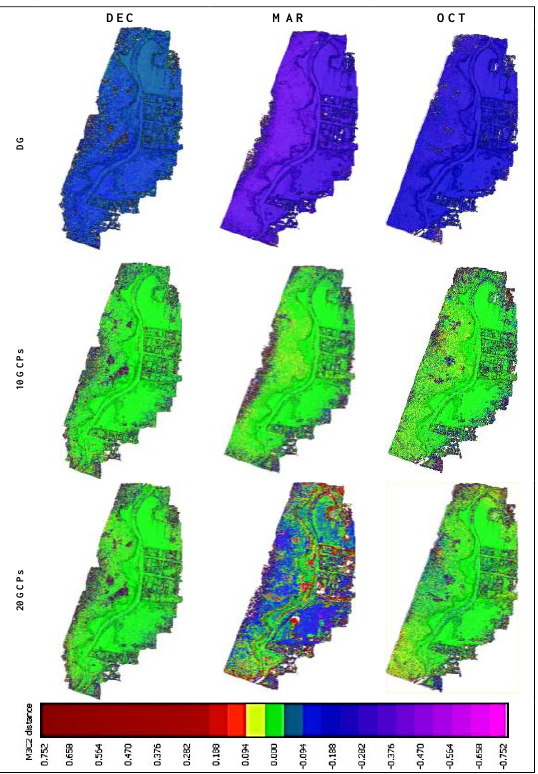
Figure 4. M3C2 maximum distance obtained by comparing dense point clouds derived from the two processing approaches for all georeferencing